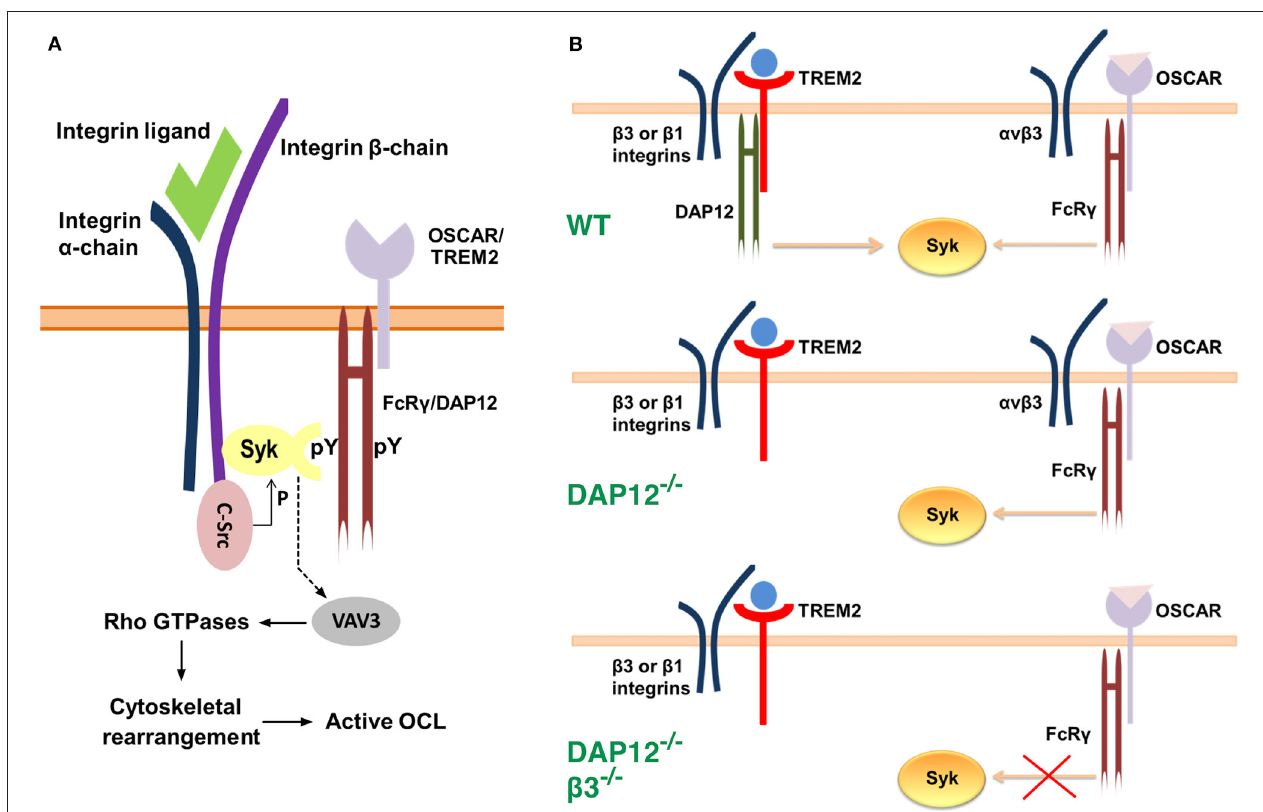
FIGURE 2 | Models for the interaction between α v β 3 integrins, c-Src, Syk and the ITAM adaptors. (A) Syk, c-Src and α v β 3 integrins associate into a multimeric complex (Zou et al., 2007). c-Src is associated constitutively with the three terminal amino acids of the β 3 integrin subunit. Binding of a ligand to α v β 3 integrin leads to phosphorylation and activation of c-Src, and to the recruitment of Syk. The latter is bound to the phosphotyrosine residues of an ITAM adaptor, FcR γ or DAP12, via its C-terminal SH2 (Src homology region 2) domain. The N-terminal SH2 domain of Syk associates with the cytoplasmic domain of the β 3 integrin subunit at a site which is distinct from that of c-Src. Activated c-Src phosphorylates Syk, which, in turn, leads to phosphorylation and activation of the guanine exchange factor Vav3. The latter alters the activity of Rho GTPases which ultimately results in reorganization of the cytoskeleton. (B) A model for OSCAR-FcR γ role in cytoskeletal rearrangement during osteoclastogenesis ( Zou and Teitelbaum, 2015). In wild-type OCLs Syk activation is achieved mainly through TREM2-DAP12 signaling in association with β 3 or β 1 integrins. Syk activation leads to cytoskeletal rearrangement. Deficiency of DAP12 is compensated by OSCAR-FcR γ , which only associates with α v β 3 integrin. Thus, deficiency of both DAP12 and α v β 3 integrin leads to impaired signaling even in the presence of OSCAR-FcR γ and consequently to cytoskeletal